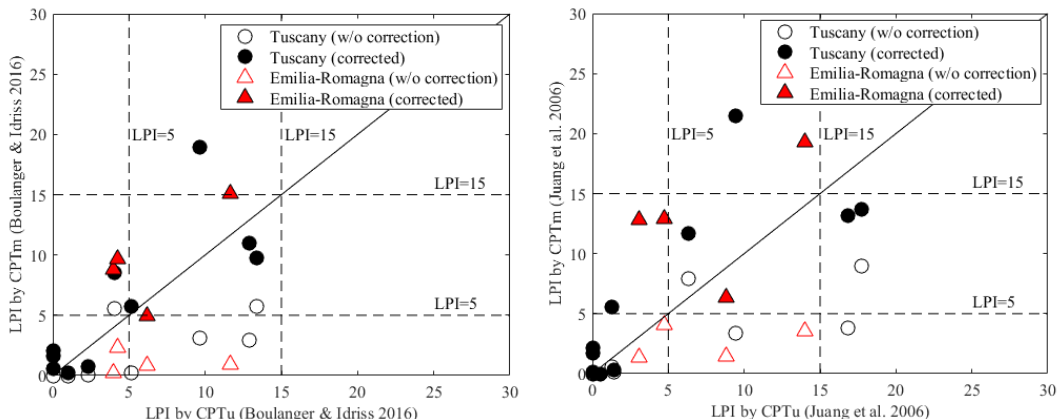
Figure 12. Comparison between the values of the LPI obtained with CPTu and CPTm (with and w / o